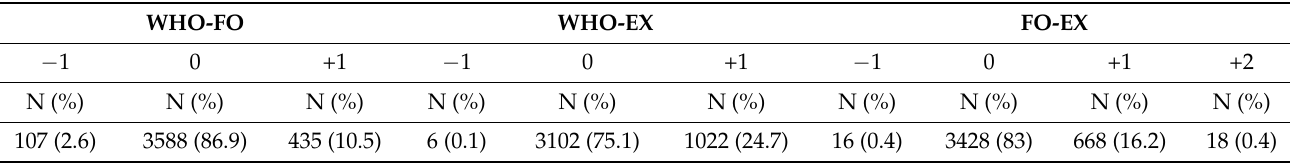
Table 3. Number of participants who have been classified in the same category and in a different category between the WHO, FO, and EX classification. WHO-FO WHO-EX